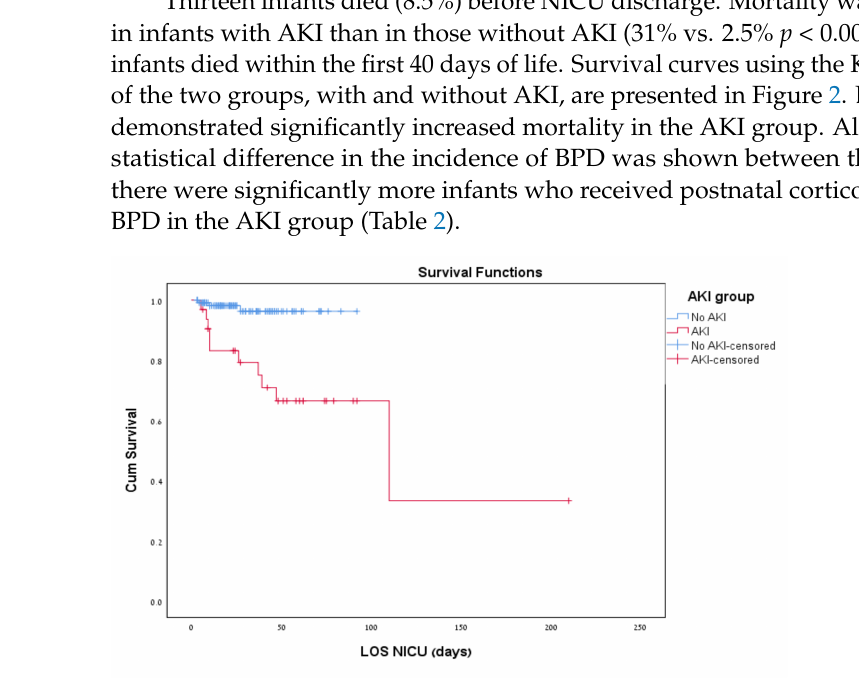
Figure 2. Kaplan–Meier survival curve for infants with and without AKI in the neonatal intensive care unit. AKI = acute kidney injury; LOS = length of